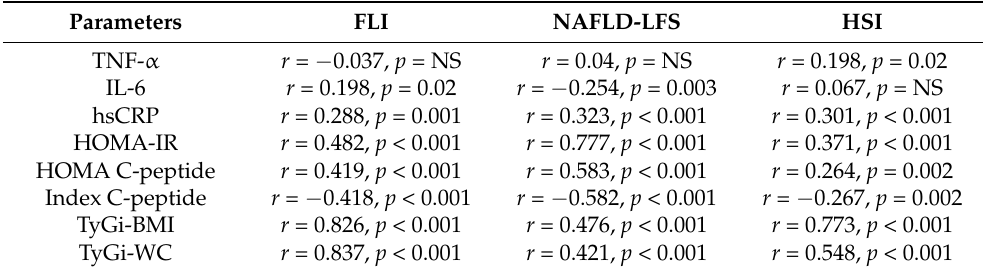
Table 5. Significant correlations between inflammation, insulin resistance, and hepatic steatosis